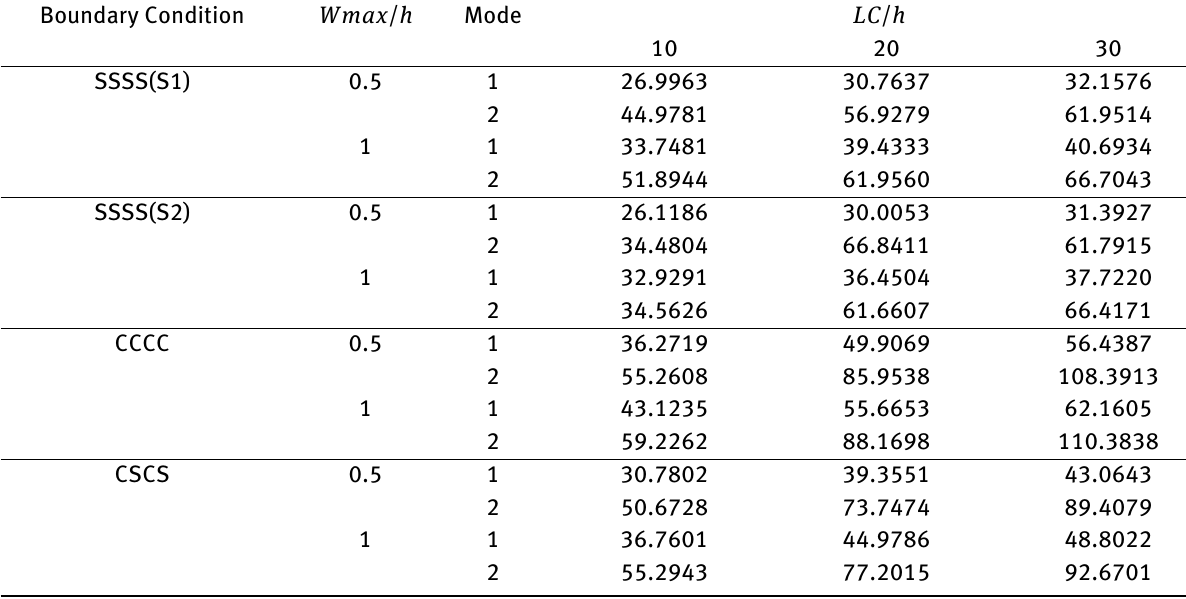
Table 9: Effect of boundary condition, amplitude ratio, frequency mode and curvature to thickness ratio on dimensionless mean nonlinear natural frequency of conical shell panel with (0 ∘ /P/90 ∘ /90 ∘ /0 ∘ ) lamination